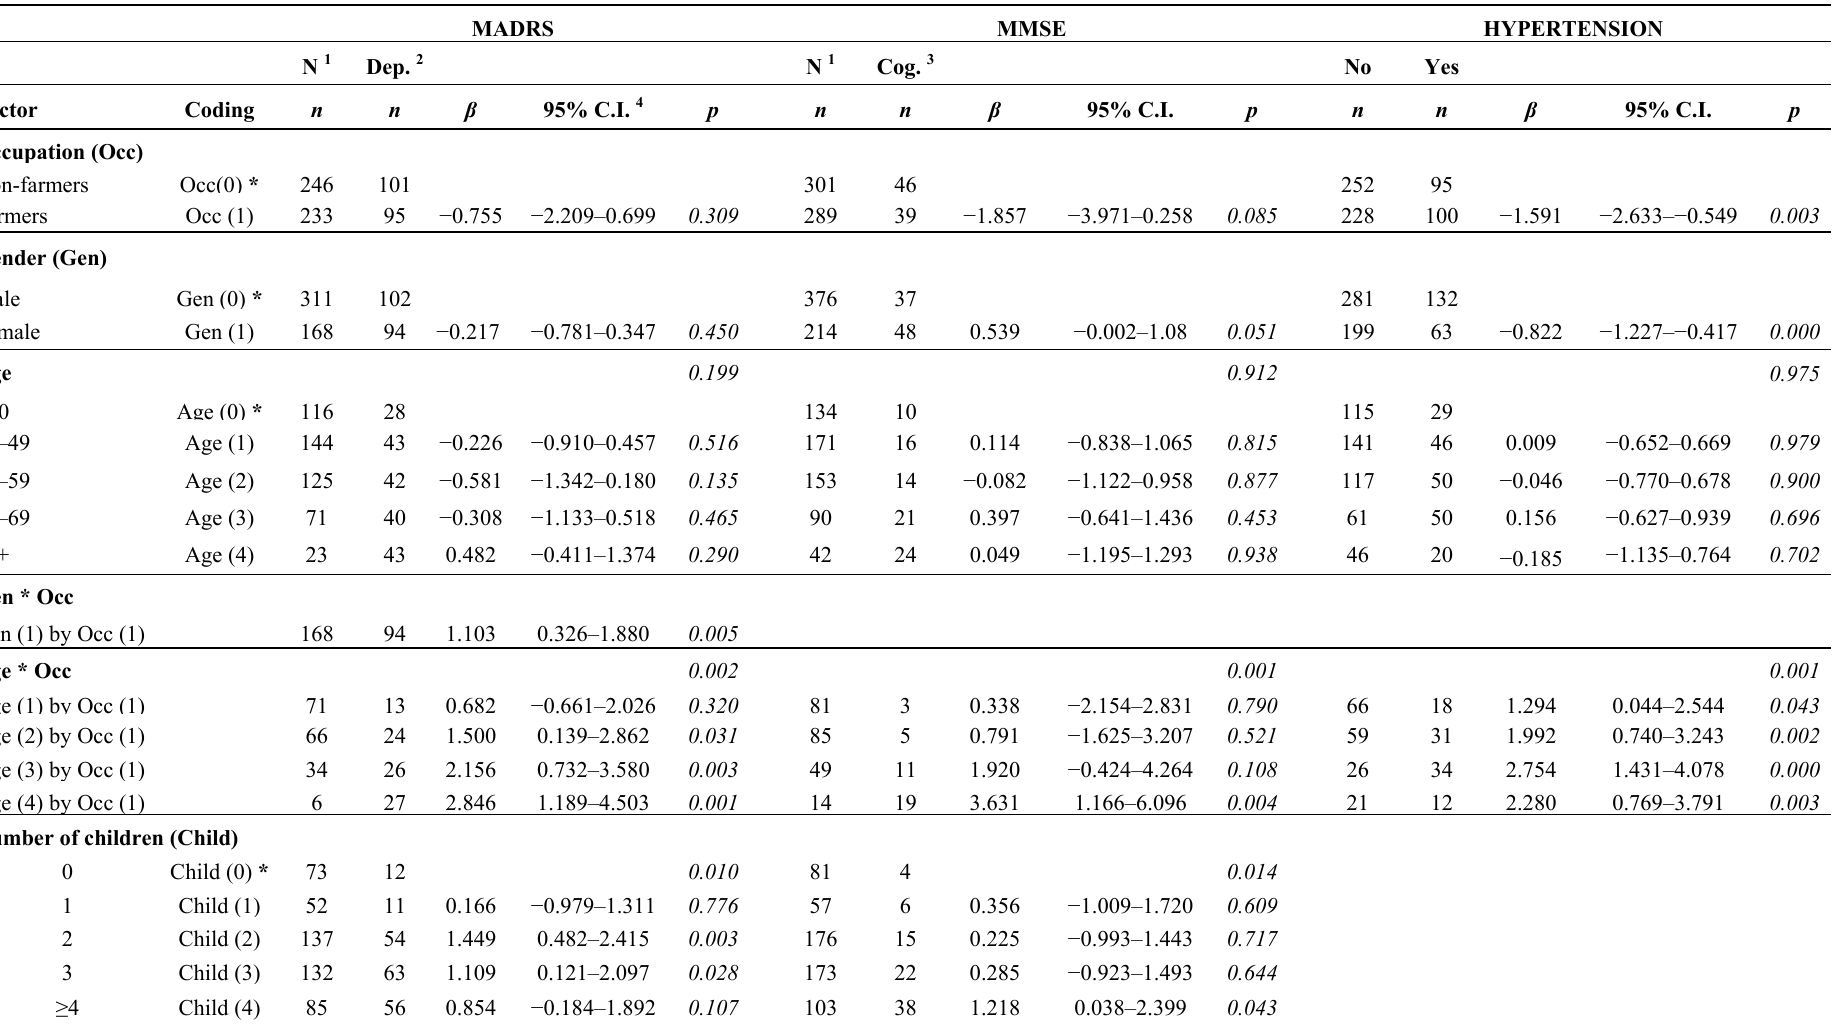
Table 5. Multivariate logistic regression